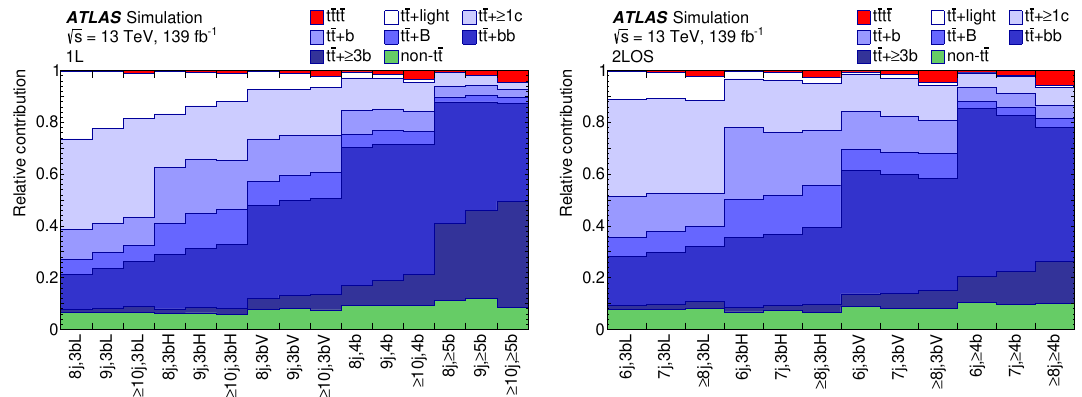
Figure 3 . Relative contribution from the signal and backgrounds in all signal, control and validation regions in the 1L channel (left) and 2LOS channel (right). The 3bL (3bH) b -tagging requirement selects events with lower (higher) purity of MC ‘truth’ b -jets amongst the three jets tagged at the 70% OP. The 3bV b -tagging requirement is used to define the validation regions. For the t ¯ t +jets background, the fraction is shown for each component with the finer classification. The t ¯ tt ¯ t signal is normalised to the SM cross-section